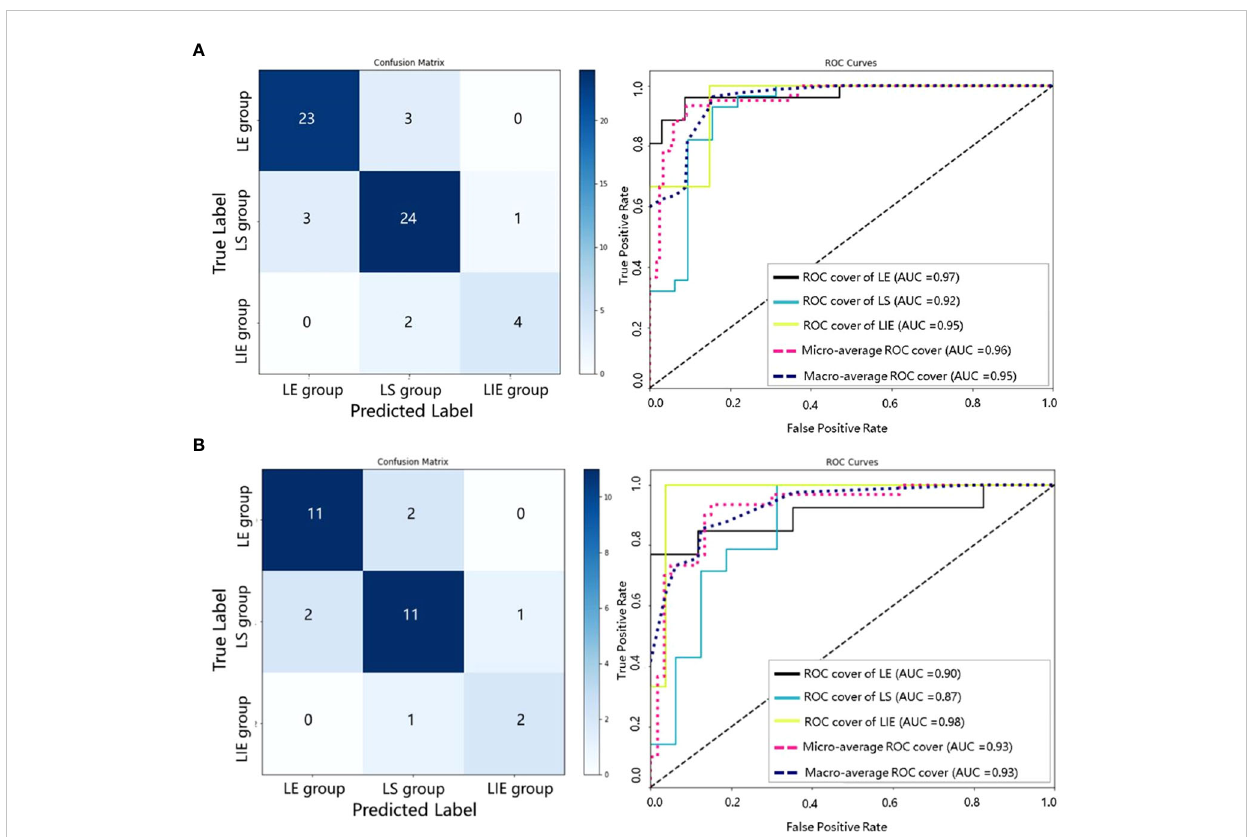
FIGURE 5 Confusion matrices and ROC curves of our SRS ef fi cacy prediction models in the internal validation set (A) and the external validation set (B)